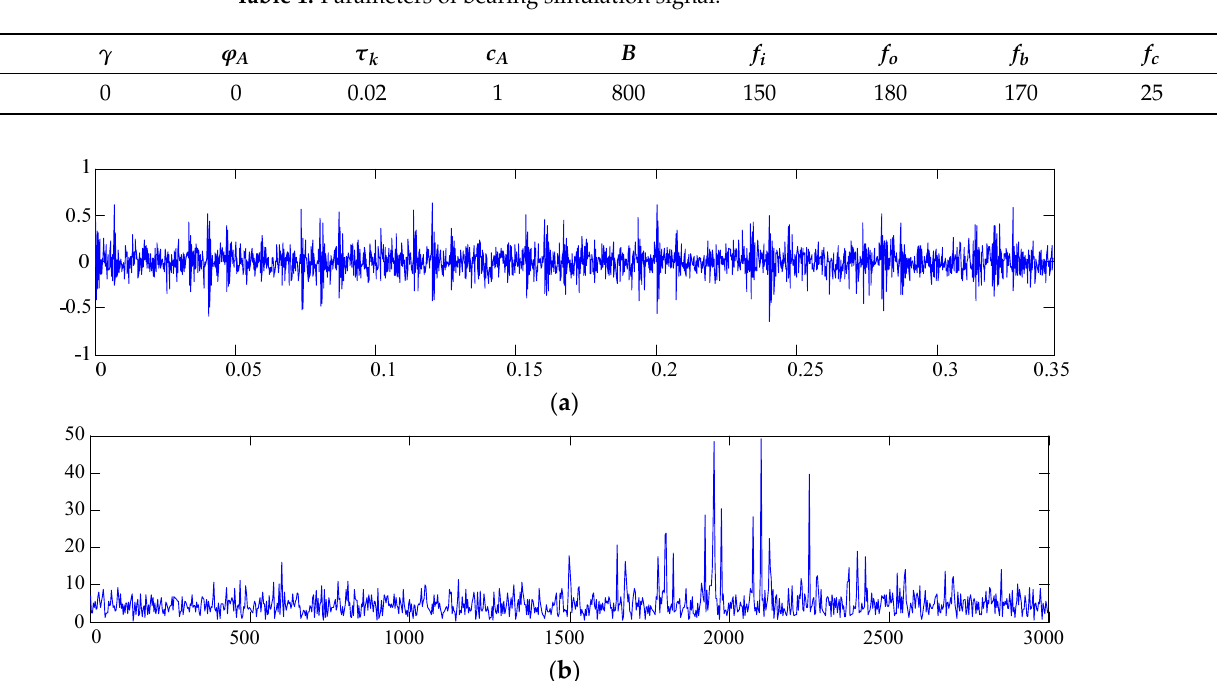
Table 1. Parameters of bearing simulation signal.